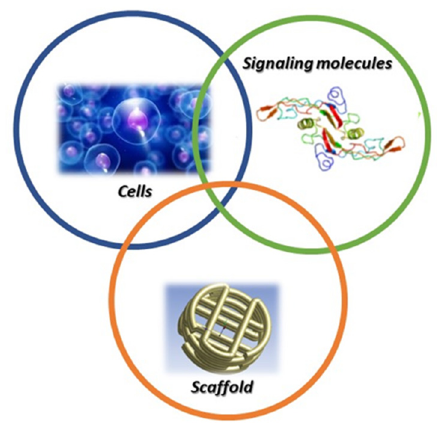
Figure 1. Tissue engineering paradigm.